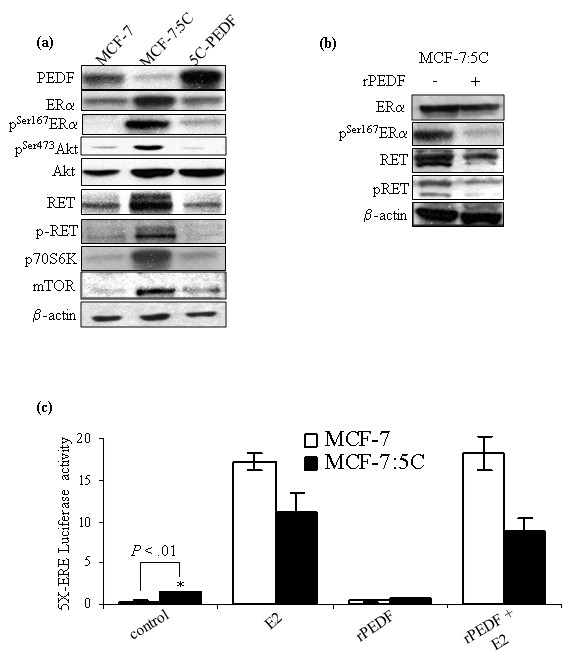
Effect of recombinant pigment epithelium-derived factor on the estrogen receptor alpha signaling pathway. (a) Western blot analysis of pigment epithelium-derived factor (PEDF), estrogen receptor alpha (ERα), phospho-ER, phospho-Akt, mitogen-activated protein kinase (MAPK), phospho-MAPK, rearranged during transfection (RET), pRET, p70S6K, and mammalian target of rapamycin (mTOR) protein expression in MCF-7, MCF-7:5C, and 5C-PEDF cells. (b) Effect of recombinant PEDF on ERα, pERα, RET, and pRET (Y1062) protein expression in MCF-7:5C cells. Cells were treated with 100 nM recombinant PEDF (rPEDF) protein for 24 hours and cell lysates were analyzed by western blot. β-actin was used as a loading control. (c) Effect of rPEDF on estrogen response element (ERE) luciferase activity in MCF-7 and MCF-7:5C cells. MCF-7 and MCF-7:5C cells were grown in estrogen-free RPMI media and then co-transfected with a 5× ERE luciferase plasmid and a renilla reporter plasmid for 24 hours. Following transfection, cells were treated with 1 nM 17β-estradiol (E2), 100 nM rPEDF, or E2 + rPEDF for 24 hours and luciferase activity was measured. Values presented as relative luciferase activity after normalization to Renilla luciferase activity. Data expressed as mean ± standard deviation of the results obtained from triplicate experiments. Basal ERE activity was statistically significantly higher in MCF-7:5C cells compared with MCF-7 cells. *P < 0.01.